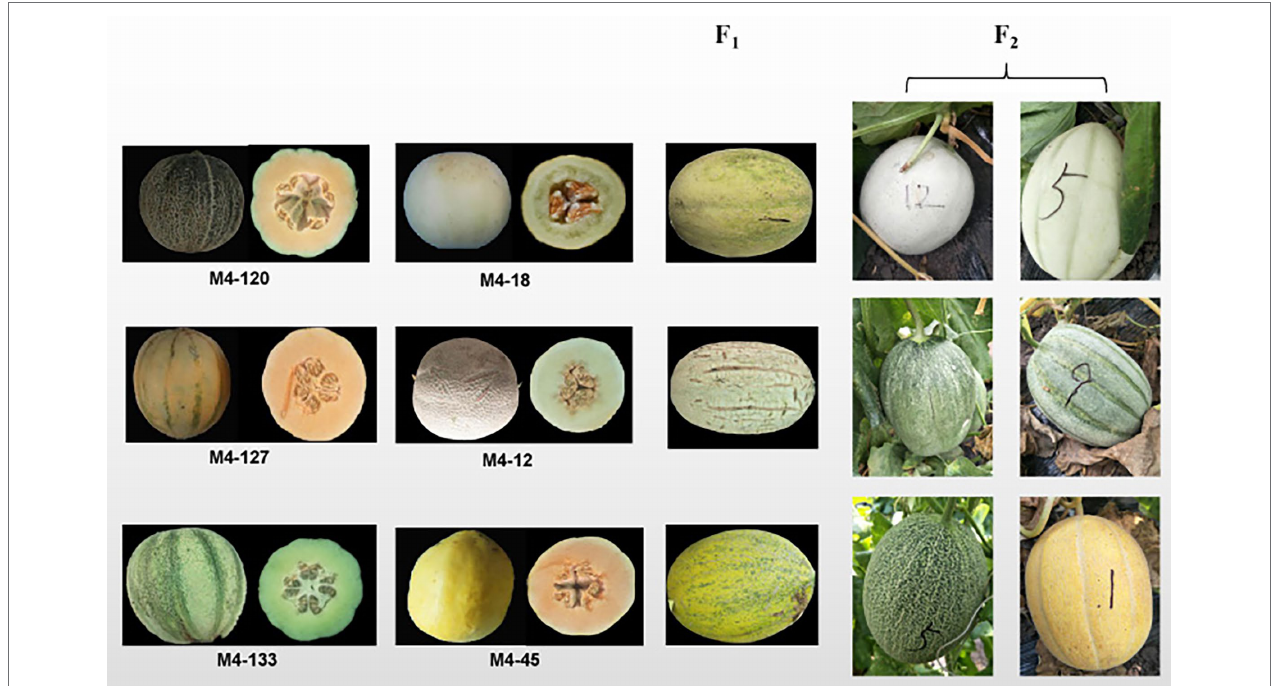
FIGURE 1 | Parental lines of the three genetic populations and the main phenotypes of the F 1 and F 2